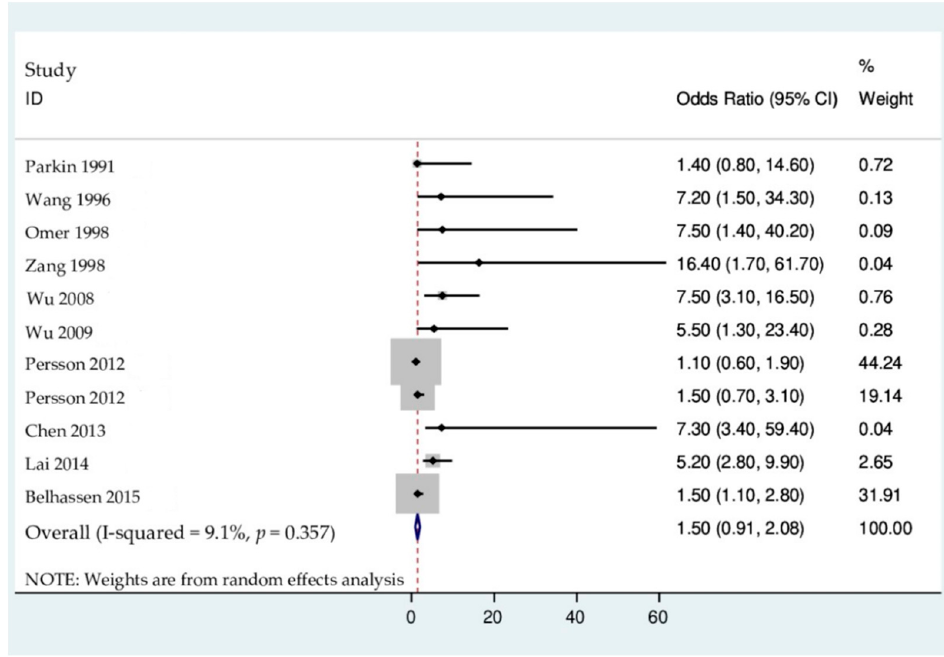
Figure 2. Forest plot of pooled meta-analysis result on association between